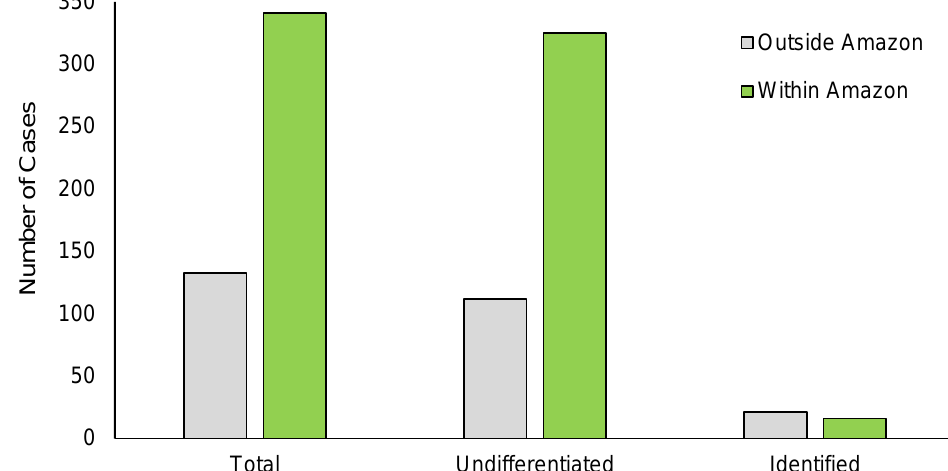
Figure 6. Total number of cases retrieved in our systematic review of the literature on in situ aerosol–PBAP research in Brazil distributed by their biological identification. Legend: “Undifferentiated” refers to the cases that did not examine the biological identity of aerosols–PBAPs; “Identified” refers to the cases that examined the biological identity of aerosols–PBAPs; “Outside Amazon” refers to the cases carried out in areas outside the Amazonian region of Brazil; “Within Amazon” refers to the cases performed within the limits of the Brazilian Amazon.